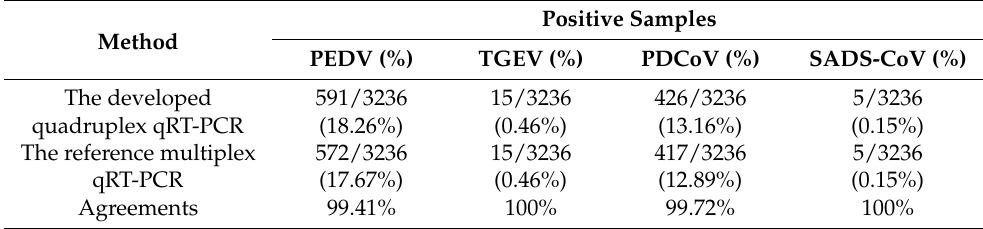
Table 5. Agreements of the detection results by the developed and the reference multiplex